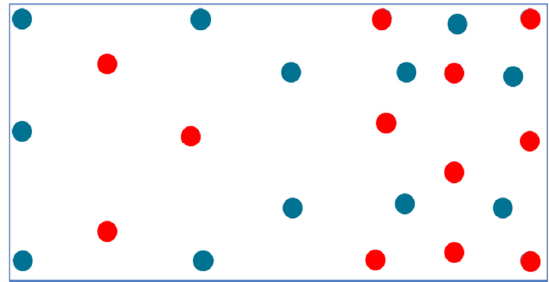
Figure 5. A schematic representation of GCPs (red dots) and CPs (blue dots) distribution. The area with well distributed GCPs is on right side of the